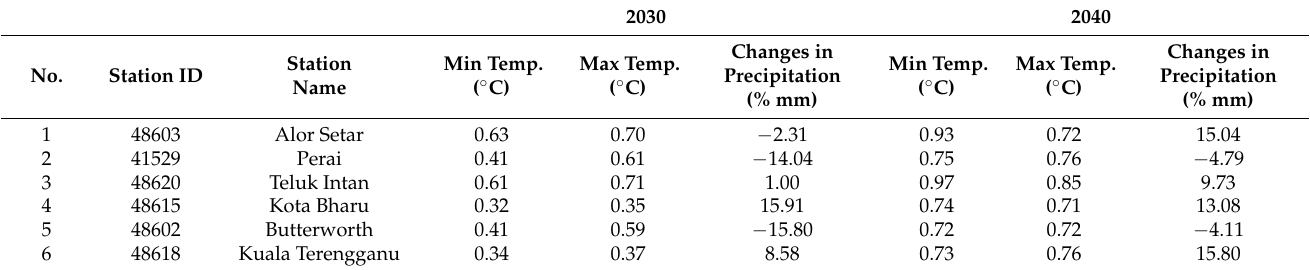
Table 3. Future climate scenario.